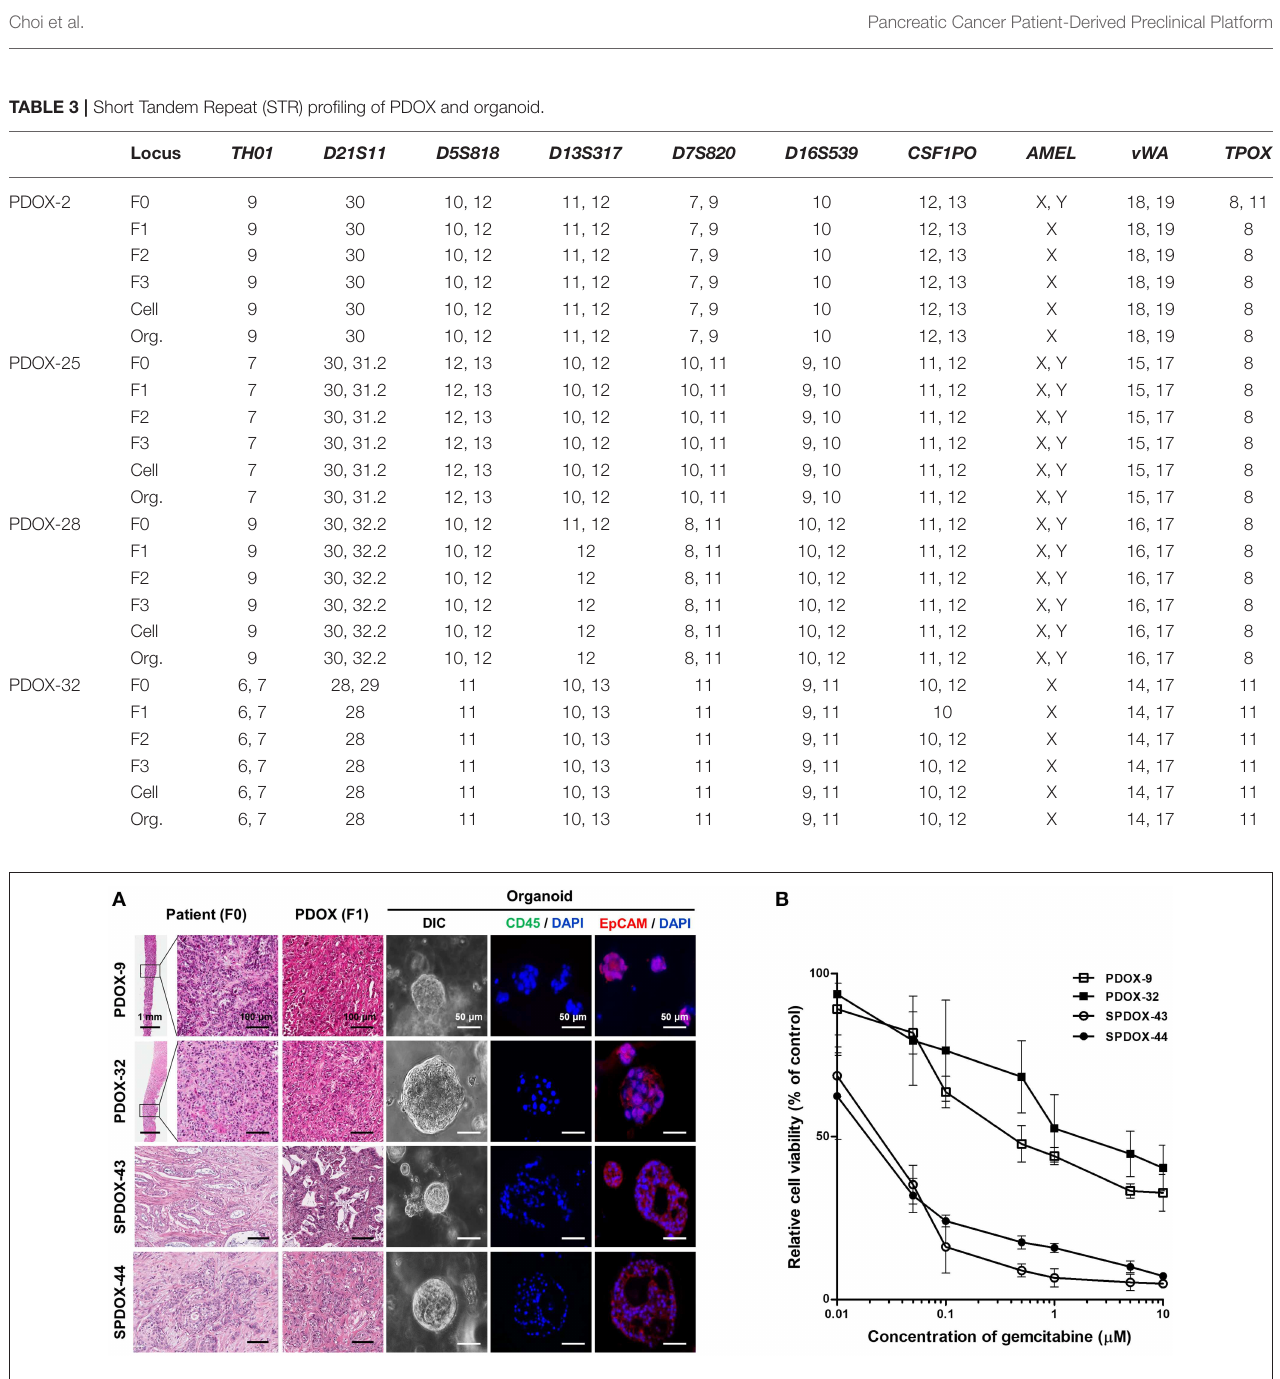
FIGURE 4 | Correlation of drug sensitivity between PDOX-derived organoids and corresponding patients. (A) Representative images of organoids derived from PDOX-9 and PDOX-32 which were generated from gemcitabine-resistant metastatic patients, and SPDOX-43 and SPDOX-44 from gemcitabine-sensitive resectable patients. Scale bar in H&E = 100 µ m, Scale bar in DIC and immunofluorescence = 50 µ m. (B) Response curves of organoids to gemcitabine. Organoids were treated with gemcitabine for 7 days, followed by measuring ATP concentrations for cell viability assay as described in “Materials and